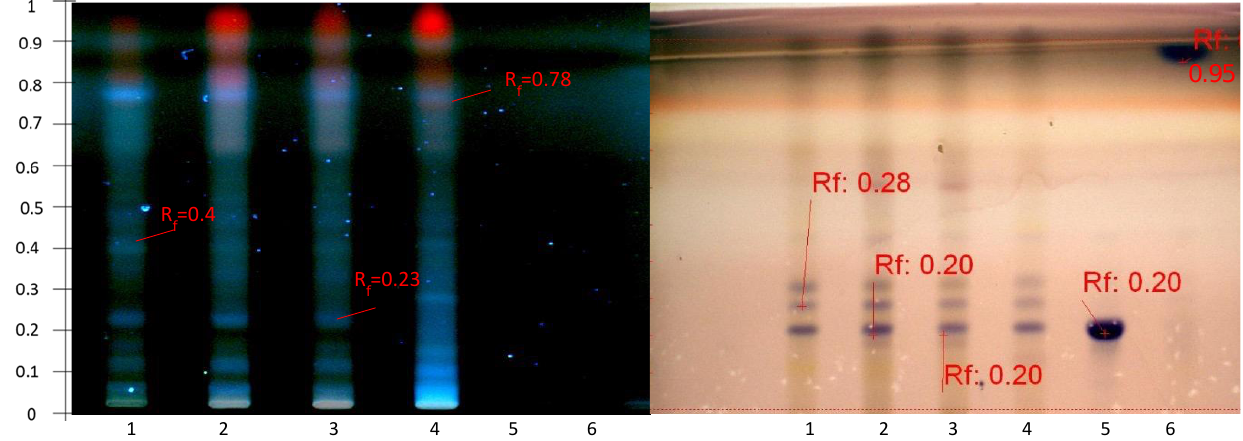
Figure 9. HPTLC profile of the four populations obtained after visualization with anisaldehyde- H 2 SO 4 : Zaghouan (Track 1), Siliana (Track 2), Bizerte (Track 3), and Kairouan (Track 4) according to P1 as well as the standards: soyasaponin (Track 5) and soyasapogenol (Track 6) using the S2 elution system.